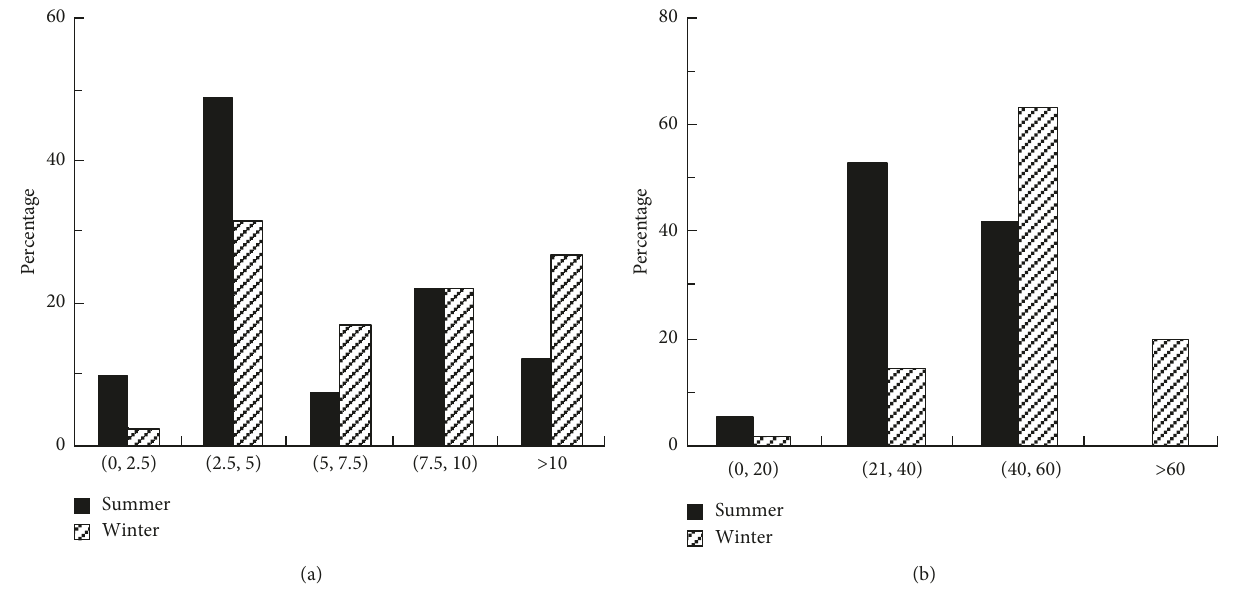
Figure 7: (a) The average time spending on cooking and (b) the average amount of firewood consumption for each meal. Table 2: Testing scenarios (Tests 1–3).